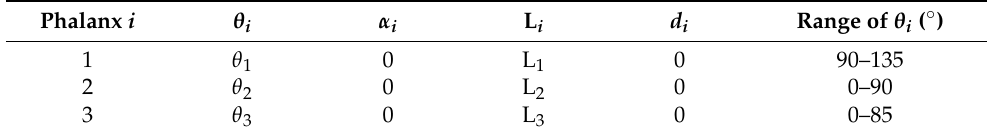
Table 4. D–H parameters of the finger.